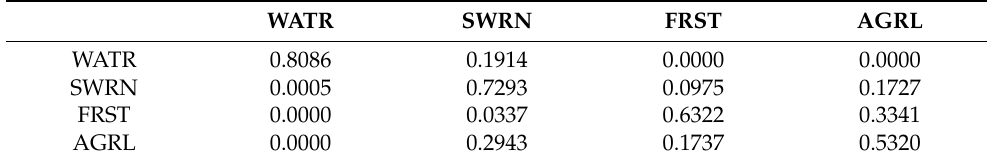
Table 1. Transition probabilities matrix for the year 2018. WATR SWRN FRST AGRL WATR